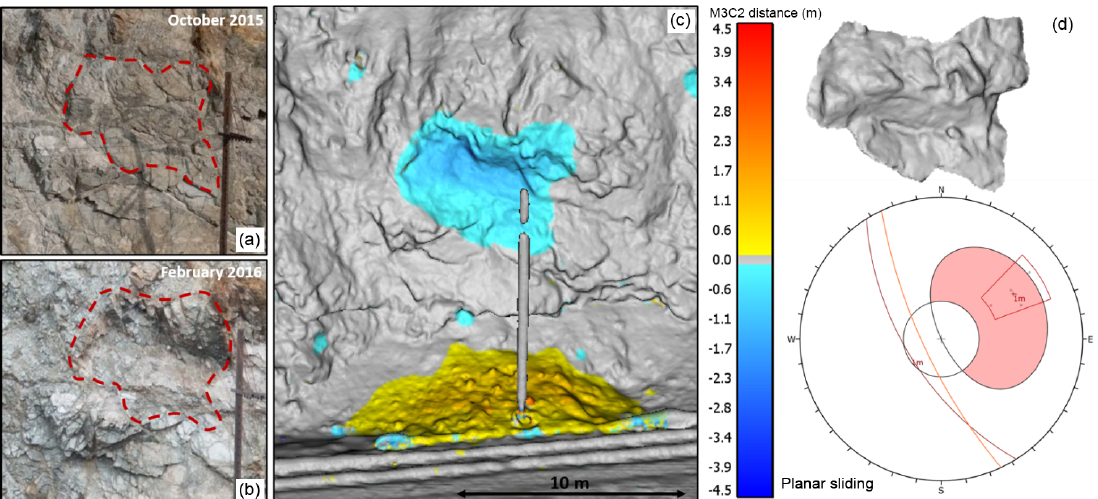
Figure 6. Site D. Schematic overview of the 15m 3 planar sliding rockfall event detected at the White Canyon West site between October 2015 and February 2016. The event involved an irregularly shaped slab of weathered and heavily jointed rock mass which failed approximately 9.5m above track level. Site photos (a, b) of the source zone pre- and post-failure are shown. Change detection results of the event are shown (c) with cool colours indicating material loss and warm colours indicating material accumulation. Change detection results indicate that the bulk of the material from the event was retained by the track-side ditch. The rockfall hull of the event extracted from the pre- and post-failure meshes is shown (d) , as well as a stereonet representation of the planar sliding failure